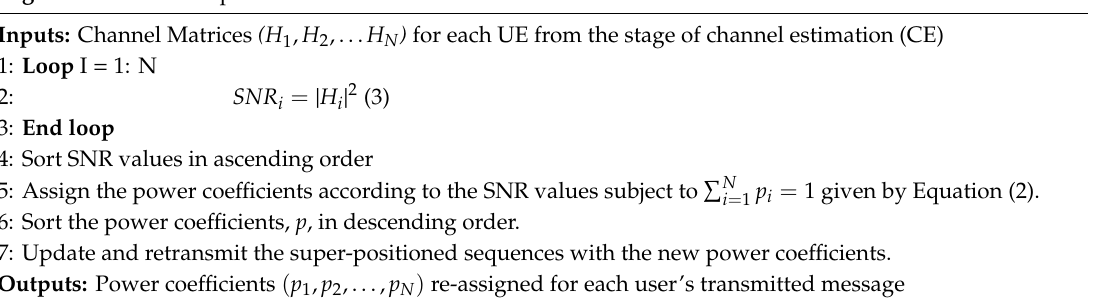
Algorithm 1 SNR comparison and Power Re-Allocation for